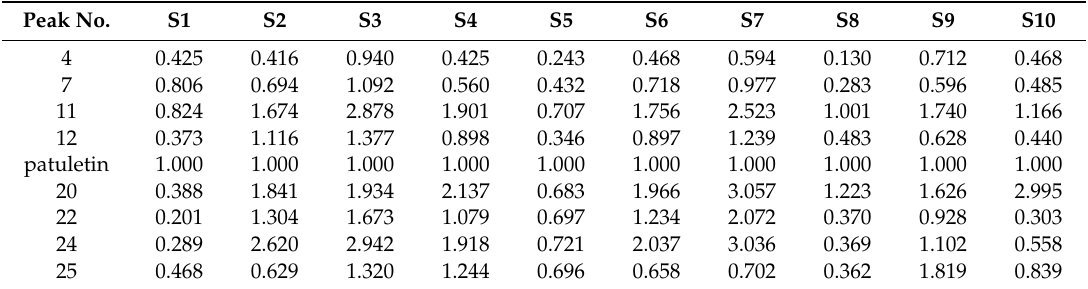
Table 2. Relative peak area (RPA) of the common peaks of the T. patula.